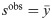
RMSE (based on a simulation study) of the toy example estimation as function of the gap size (Δ) and number of nearest neighbors selected to carry out the interpolation (N).The left panel is called situation 1 in which sobs=y¯ and the right panel is situation 2 (sobs=y¯2). For the second situation, the trade-off between Δ and N is clearly visible.